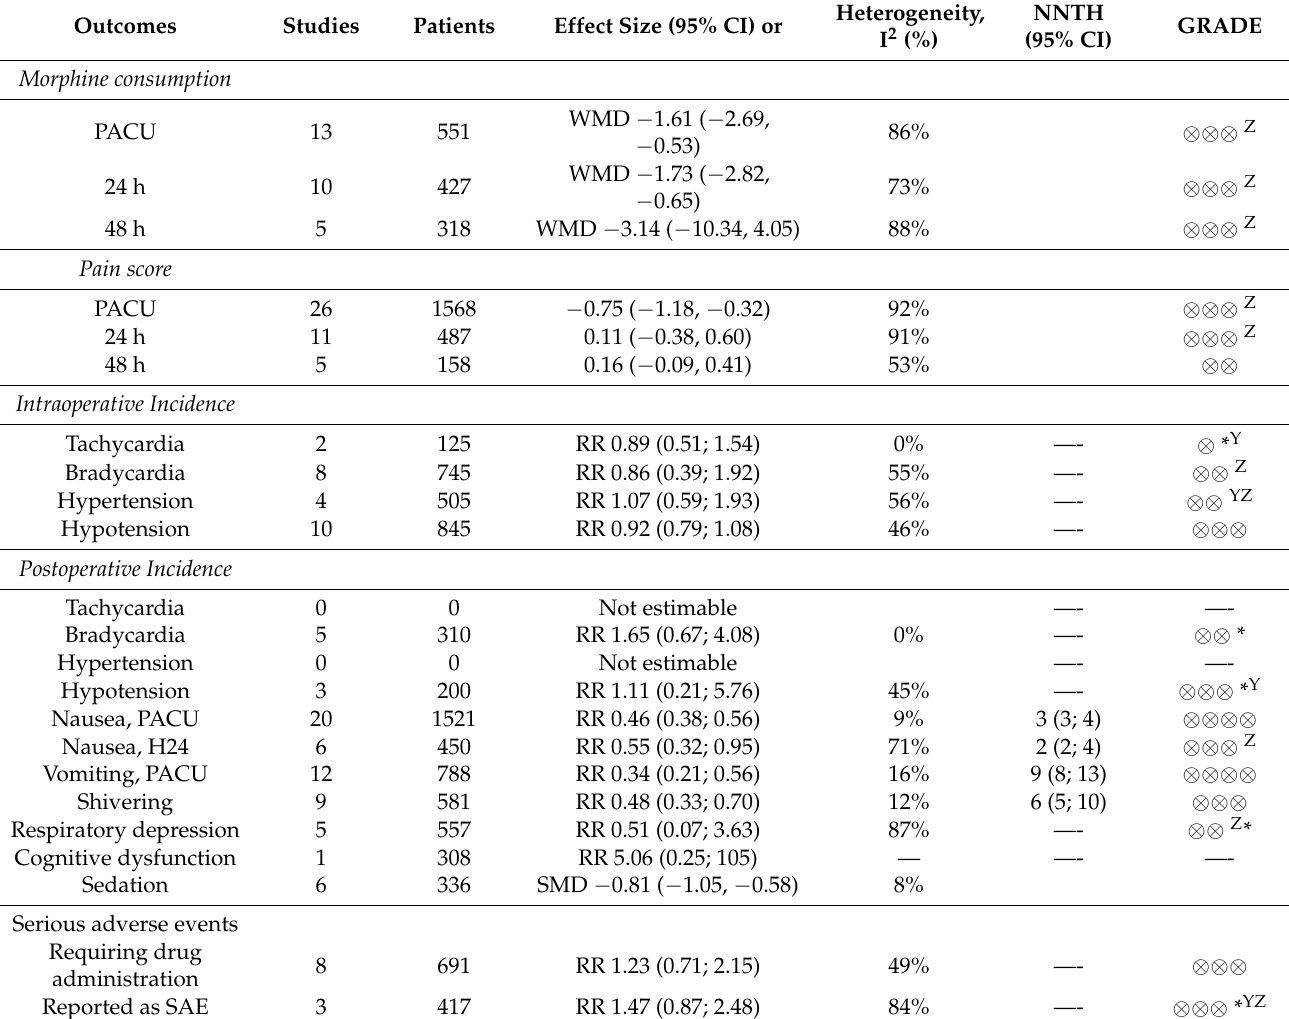
Table 2. Summary of the findings from pairwise meta-analyses and the level of